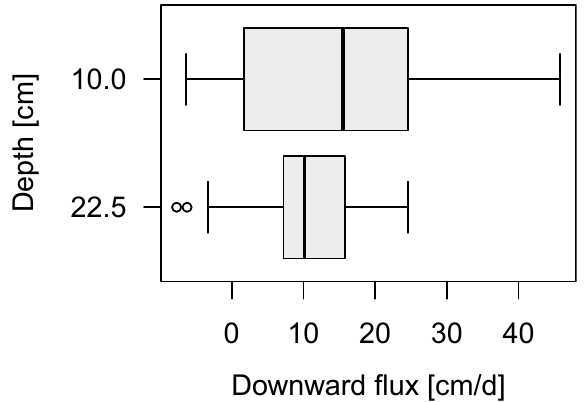
Figure 1. Seepage flux directions and velocities in 10.0 and 22.5 cm sediment depth calculated by the VFLUX 2.0 model using time series of temperature depth profiles (method: McCallum).